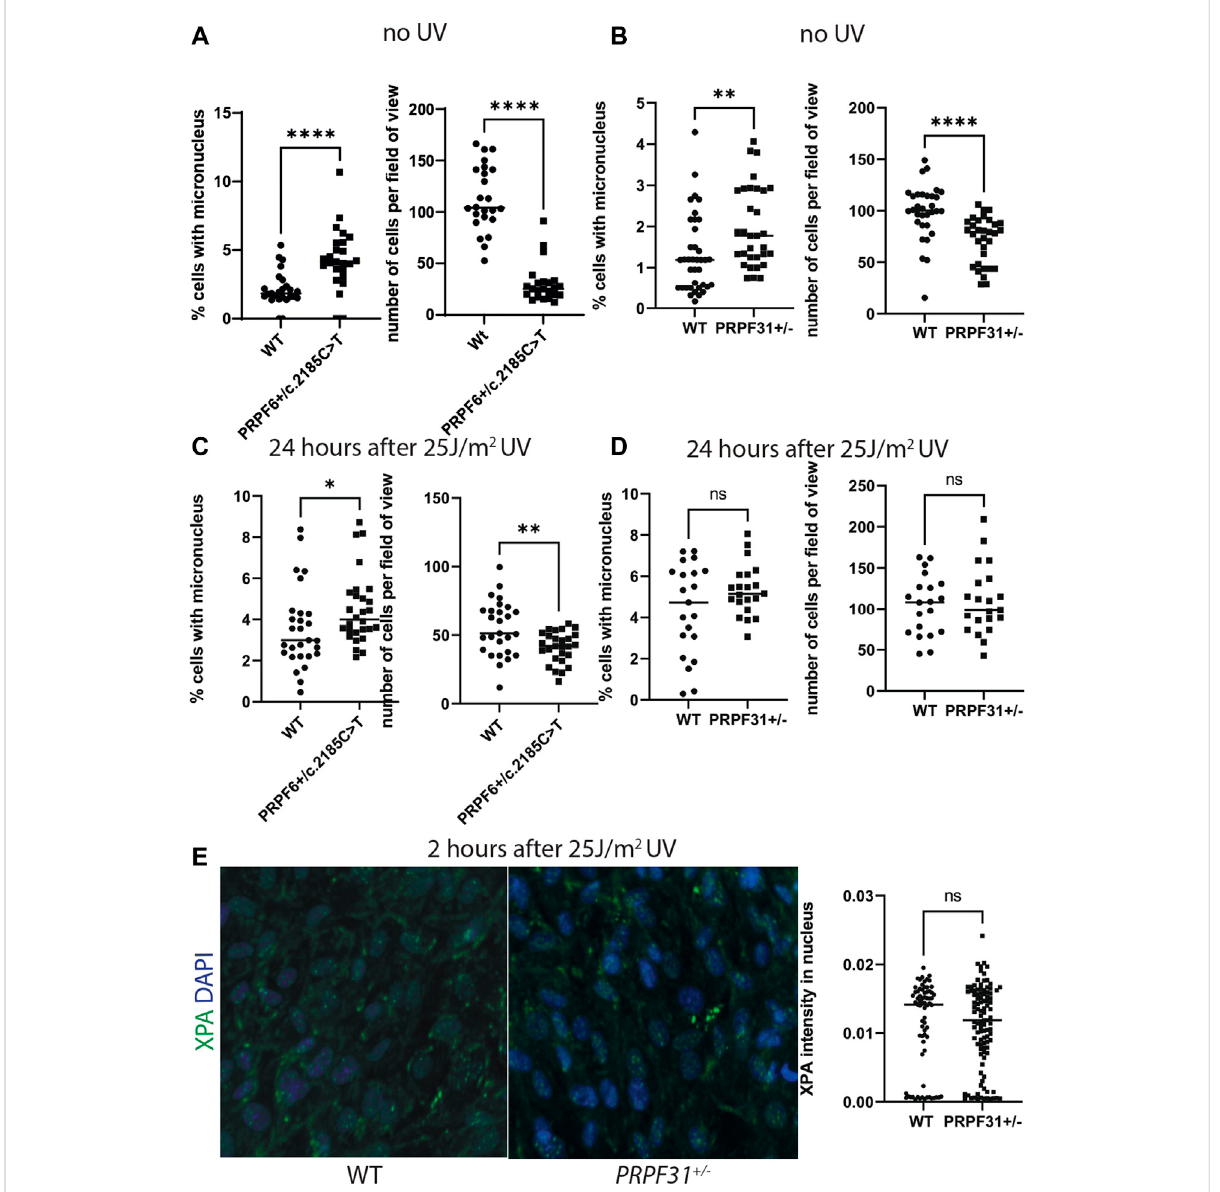
FIGURE 4 Analysis of micronucleusand cell number in PRPF6 +/c.2185C > T cells and PRPF31 +/ − cells before and after UVexposure,and analysis of XPA nuclear stainingin PRPF31 +/ − cellsafterUVexposure. (A) Dotplotsshowingpercentageofcellswithamicronucleus(left)andnumberofcellsper fi eldofview (right) in untreated WT cells and PRPF6 +/c.2185C > T cells. PRPF6 +/c.2185C > T cells have statistically signi fi cantly more micronuclei and statistically signi fi cantly fewer cells. (B) Dot plots showing percentage of cells with a micronucleus (left) and number of cells per fi eld of view (right) in WT cells and PRPF31 +/ − cells. PRPF31 +/ − cells have statistically signi fi cantly more micronuclei and statistically signi fi cantly fewer cells. (C) Dot plots showingpercentageofcellswithamicronucleus(left)andnumberofcellsper fi eldofview(right)inWTcellsand PRPF6 +/c.2185C > T cells24 hafter25 J/ m 2 UV. PRPF6 +/c.2185C > T cells have statistically signi fi cantly more micronuclei and statistically signi fi cantly fewer cells, but these differences are less statisticallysigni fi cantthaninuntreatedcells. (D) Dotplotsshowingpercentageofcellswithamicronucleus(left)andnumberofcellsper fi eldofview (right) in WT cells and PRPF31 +/ − cells 24 h after 25 J/m 2 UV. PRPF31 +/ − cells do not have statistically signi fi cantly more or fewer micronuclei, nor statistically signi fi cantly more or fewer cells. (E) Confocal image (left) of WT and PRPF31 +/ − cells immunostained with XPA (green) and DAPI nuclear stain (blue) and dot plot (right) of XPA staining intensity in nucleus 2 h after 25 J/m 2 UV exposure. No statistical difference is seen in mutants compared to WT